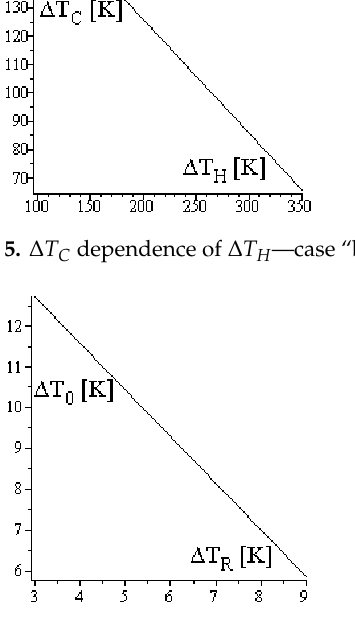
Figure 6. ∆ T 0 dependence of ∆ T R —case Figure 6. Δ T 0 dependence of Δ T R —case “b”. Figure 6. Δ T 0 dependence of Δ T R —case “b”. Figure 6. Δ T 0 dependence of Δ T R —case “b”. Figure 6. Δ T 0 dependence of Δ T R —case “b”.